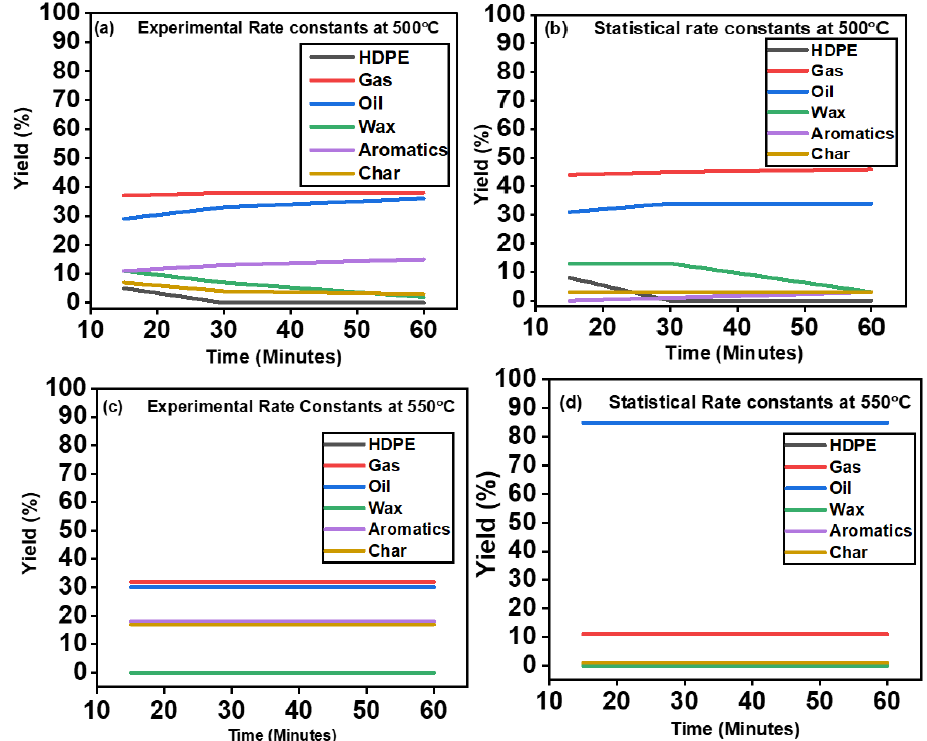
Figure 7. The time-dependent conversion of HDPE into species as a function of time and temperature: ( a ) the experimental rate constants at 500 °C, ( b ) the statistical rate constants at 500 °C, ( c ) the experimental rate constants at 550 °C, and ( d ) the statistical rate constants at 550 °C. Figure 7c,d shows that after 15 min of reaction time at 550 °C, no HDPE was left. The oil, gas, aromatics, and char yield increased progressively for the experimental rate con- stants at 550 °C. The highest determined oil output for the experimental rate constants was 32%. In the case of the statistically predicted rate constants, the oil yield increased dramatically up to 85%, with 11% of the gas output. The wax completely degraded into oil and gas products at this temperature. The char and aromatic production remained at almost 1%. The low char yield was attributed to the high temperature, reactor size, and low Ea values. The high average kinetic energy of the molecules boosted the collusion of molecules during the reaction. The collision hypothesis was attributed to the drop in pri- mary products for the experimental rate constants at 550 °C. The collusion theory posits that if the Ea is significantly higher than the entire energy of the atoms, the reaction will proceed slowly. Only a small number of rapid molecules can react and generate oil or other products [31]. The number of molecules with the necessary kinetic energy will be higher if the activation energy is significantly less than the kinetic energy of the molecules. Excessive collisions between these molecules will accelerate the pyrolysis process [31]. It was determined that the value of Ea must be less than the molecules ’ kinetic energy to overcome this barrier. 6. Comparison with Literature Yang et al. [32] obtained 43% oil through the fast co-pyrolysis of cedar wood and sunflower stalks at 600 °C. Fast co-pyrolysis of materials is a key inducer of an increased oil yield. The highest oil yield was observed at a temperature of 600 °C, which was sub- stantially higher than the optimized process temperature. The inorganic substance in